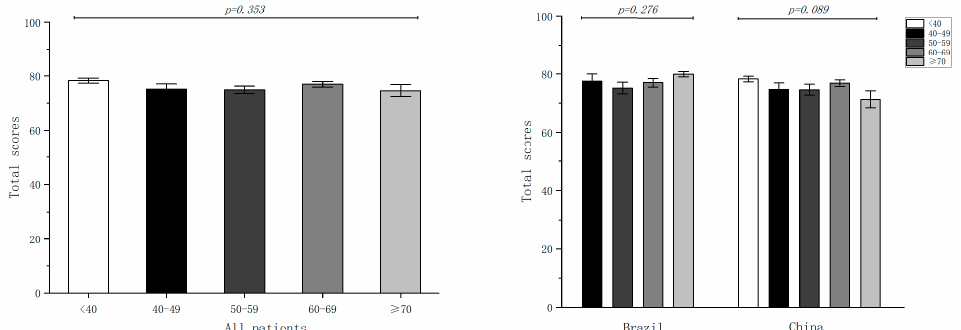
Figure 2. Comparison of total scores between genders.